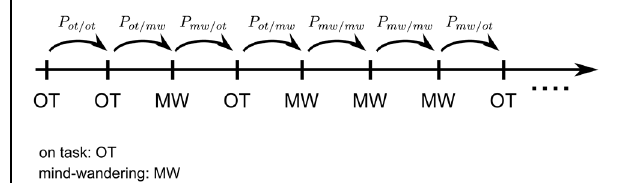
FIGURE 3 | Markov Chain of attentional states. Illustrative time series of on-task (OT) and mind wandering (MW) states, with two pairs of complementary probability transitions to stay (ex. P ot / ot : stay focused) in the same state or transition (ex. P ot / mw = 1 − P ot / ot : start mind wandering) to the other.